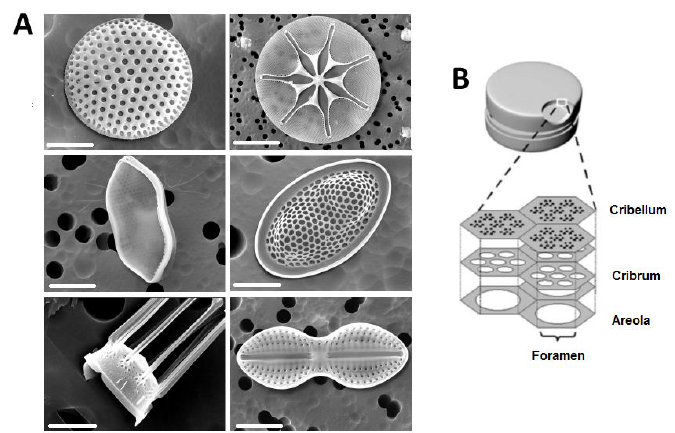
Figure 1. ( A ) Scanning electron microscopy (SEM) images of the cell walls of different diatom species. ( B ) Illustration of a centric diatom frustule with cross-sectional profile of the silica wall typically formed by three overlapping porous layers: cribellum, cribrum, and areola. Reproduced with permission from [28], Springer,